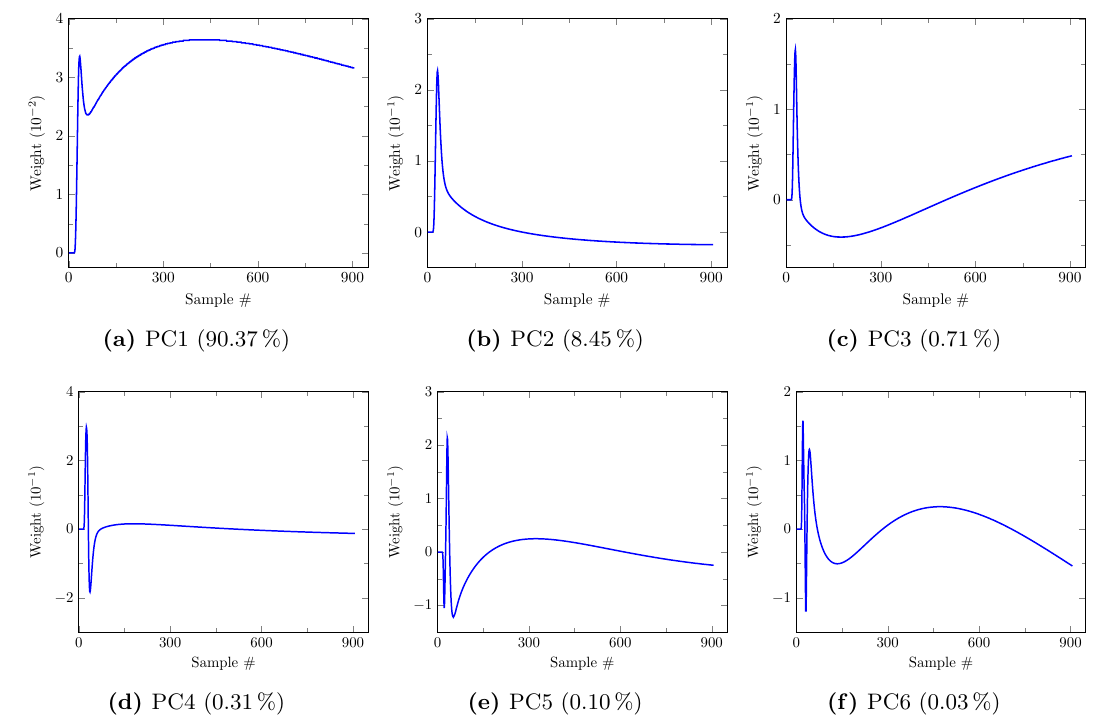
Figure 3. First 6 principal components (PCs) with their explained variance ratio determined on the synthetic model-building dataset (20 patients, 3,974,466 TACs) for a noise level of zero. Each component assigns a weight to each of the 906 TAC samples, starting from 10 s to 1820 s with step 2